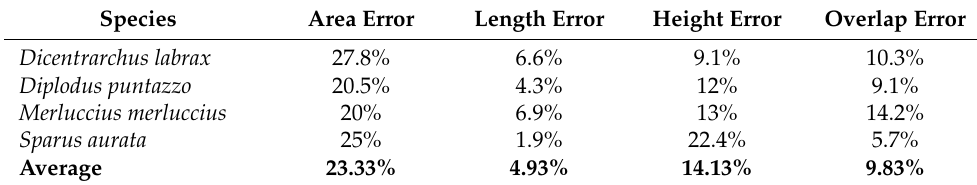
Table 1. Dimension errors for the image processing approach of Figure 1.